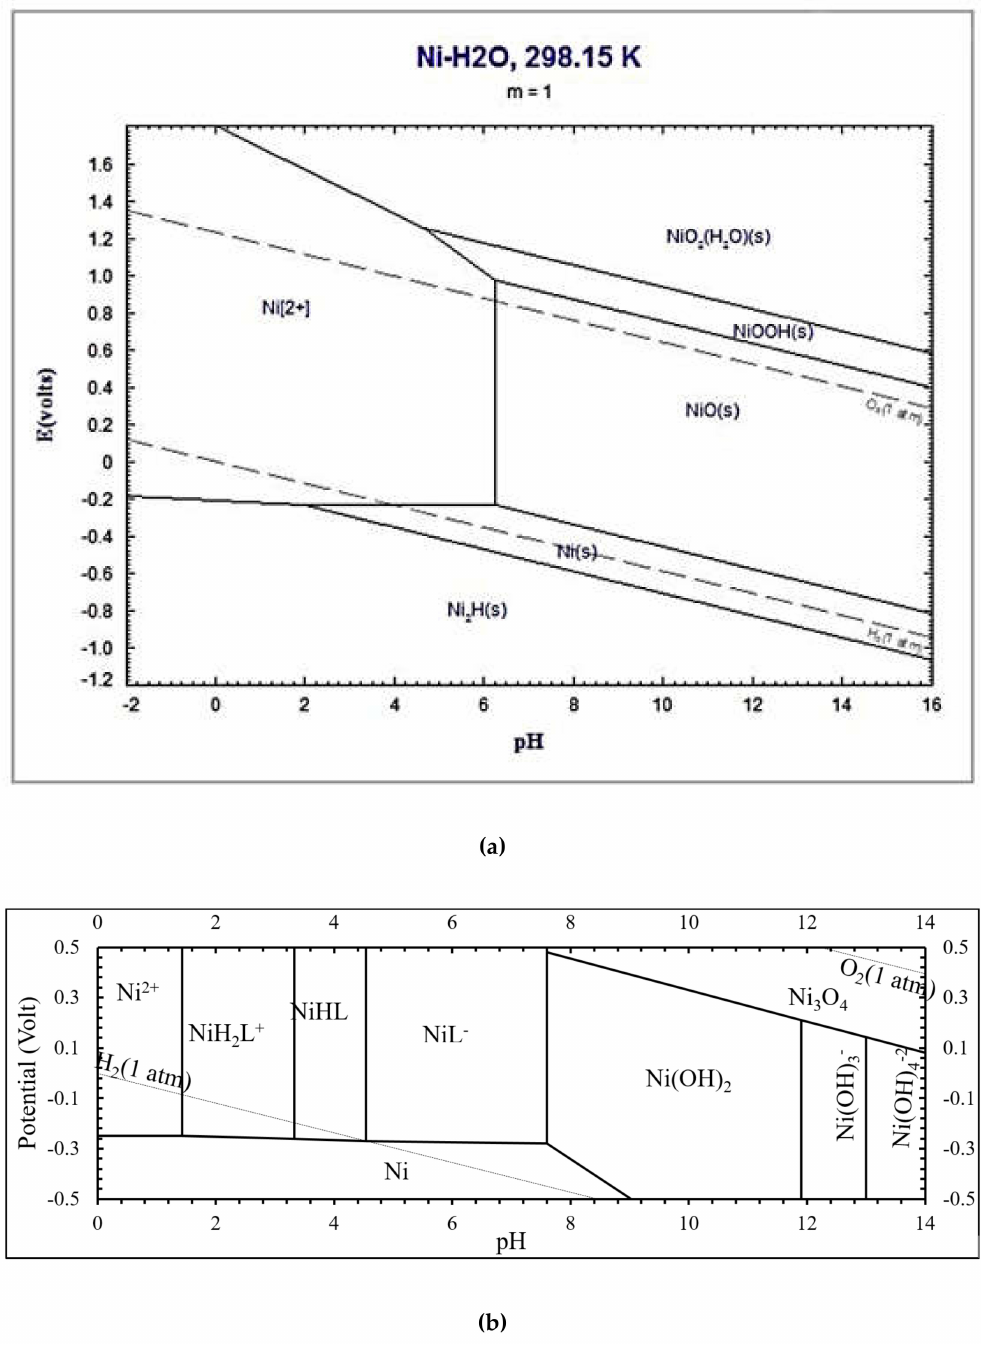
Figure 8. Pourbaix diagram for ( a ) Ni-H 2 O system; ( b ) Ni-H 2 O-citrate system at 298 K (total nickel activity = 1 M, total citrate activity = 0.667